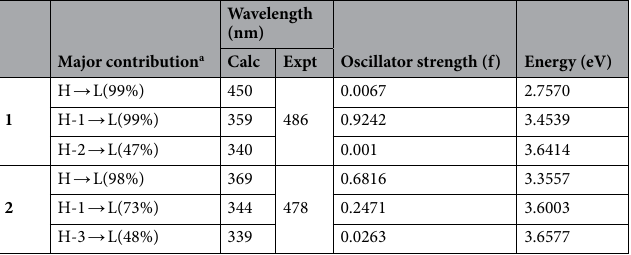
Table 5. Electronic absorption spectral data of 1 and 2 molecules. a H: HOMO, L: LUMO.